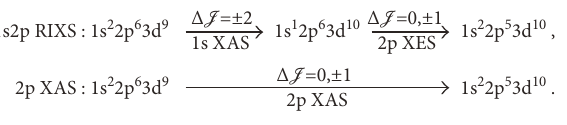
Figure 5: Calculated atomic 1s2p RIXS map with 2p XES projection for an isolated Cu 2+ (3d 9 ). Notice the 2p XAS (L has only one peak, because only the fi nal state with J = 3/2 can be populated. See also Figure 7.3 in Core Level Spectroscopy of Solids